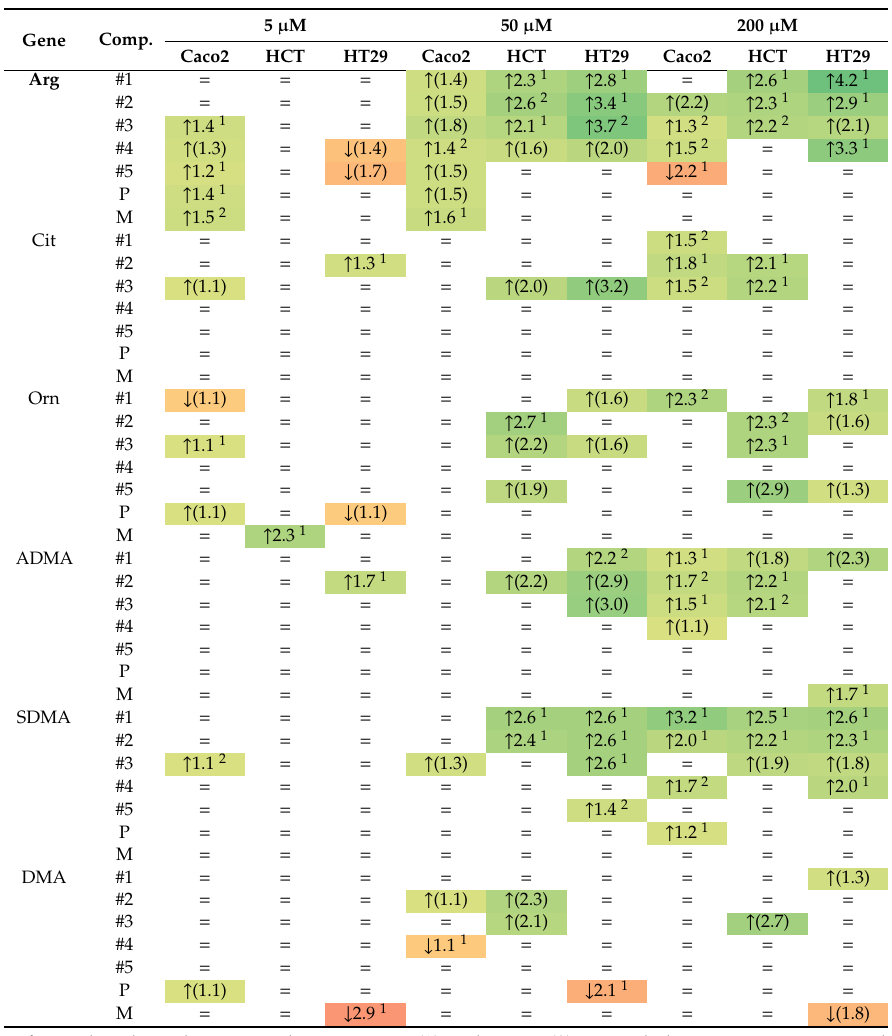
Table 2. E ff ect of Classic and Novel Oxicam Analogues on the Intracellular Level of Key Metabolites of Arginine / Nitric Oxide